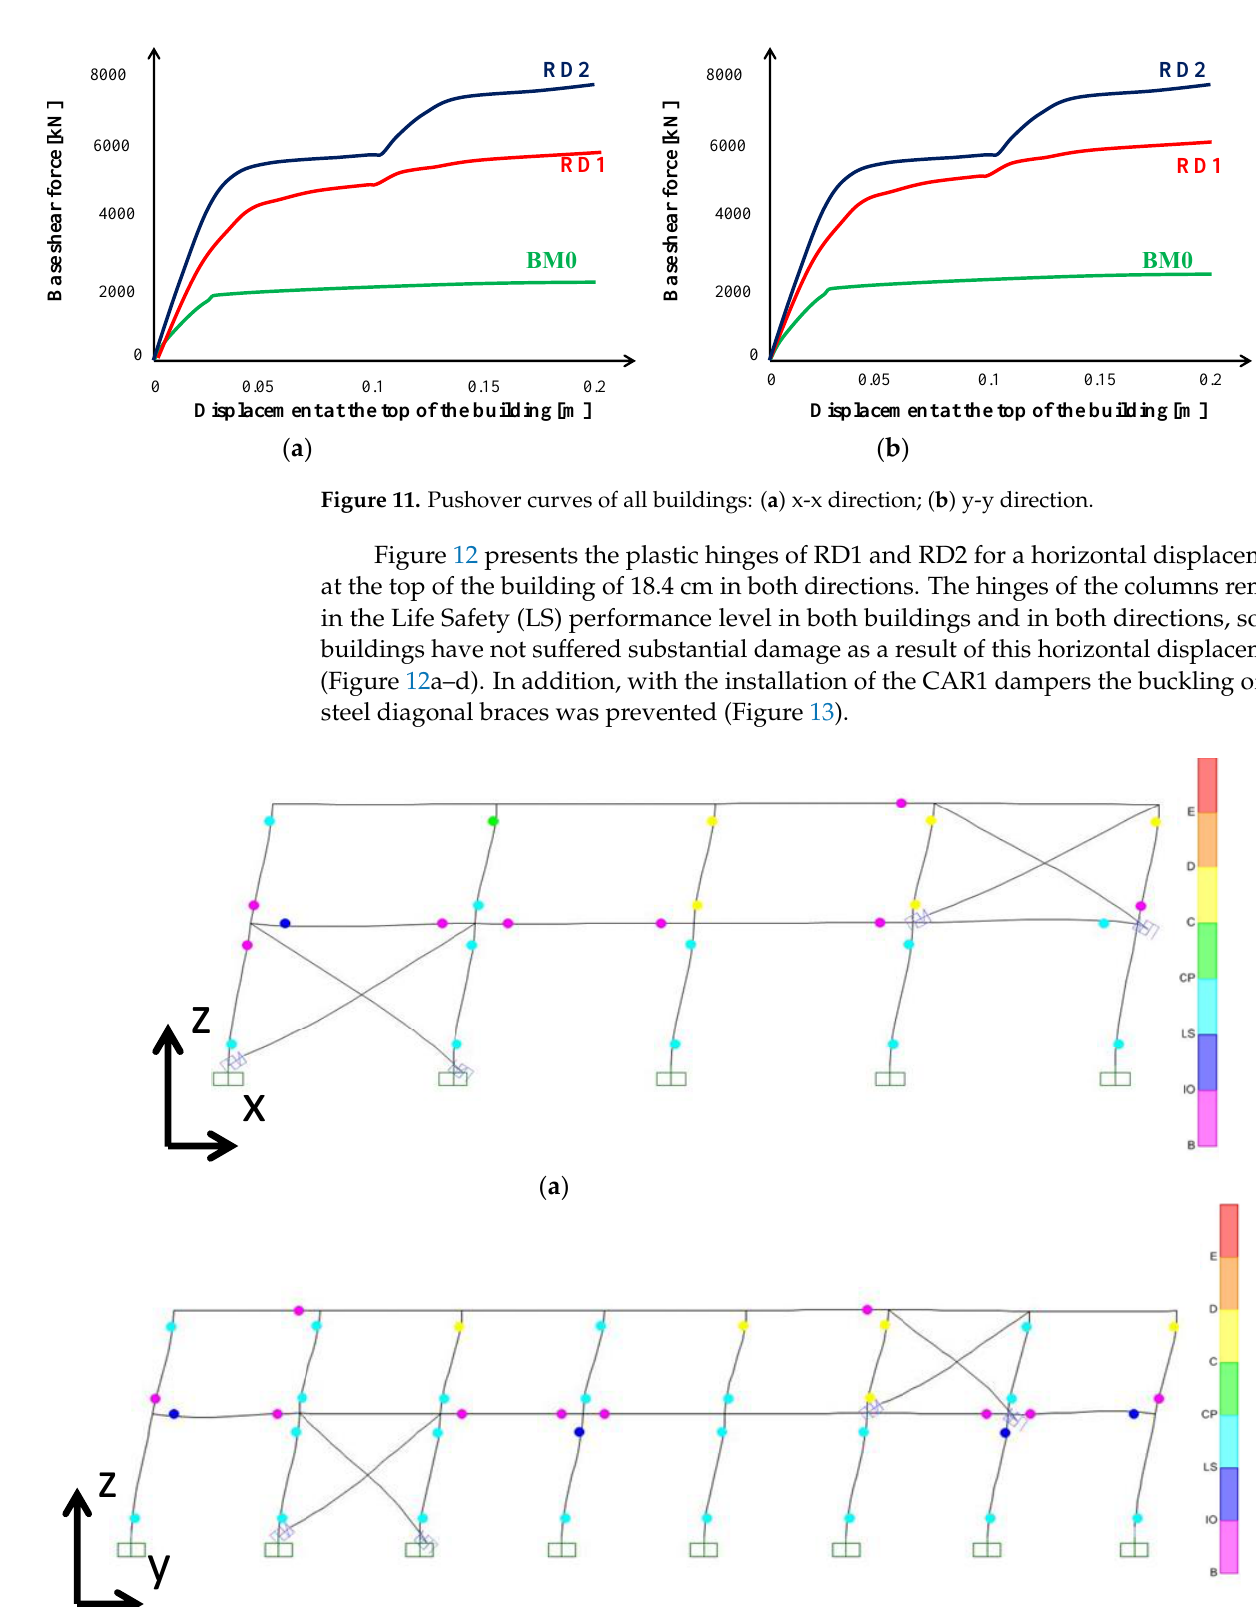
314 Table 3. Description of the selected characteristics of the CAR1 dampers for RD2.